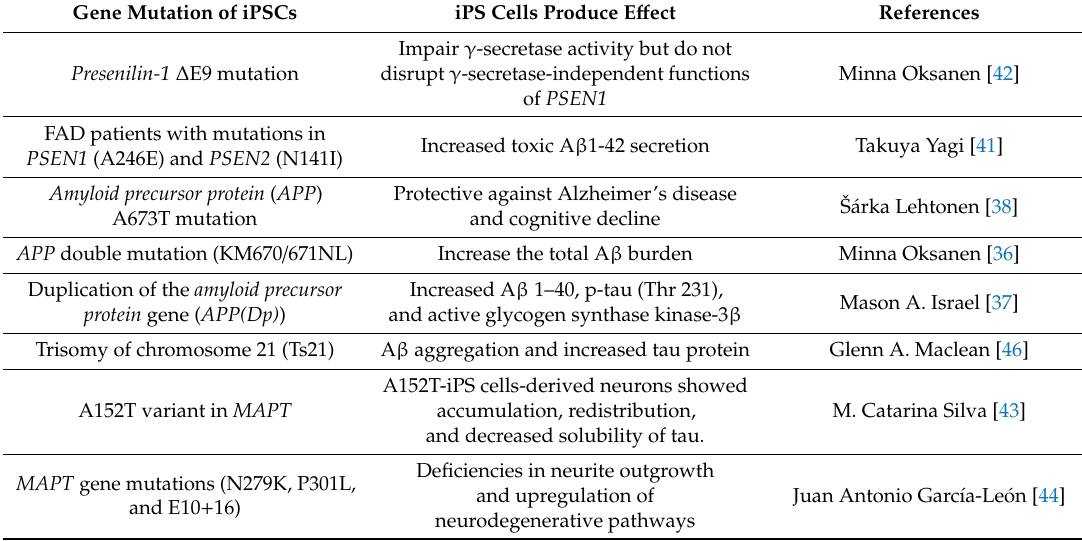
Table 1. Alzheimer’s diseases modeled with induced pluripotent stem (iPS)